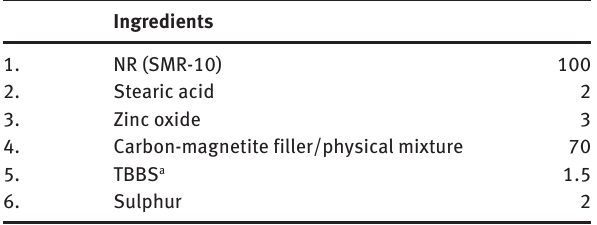
Table 1: Formulation of the studied NR based compounds (in parts per 100 parts of